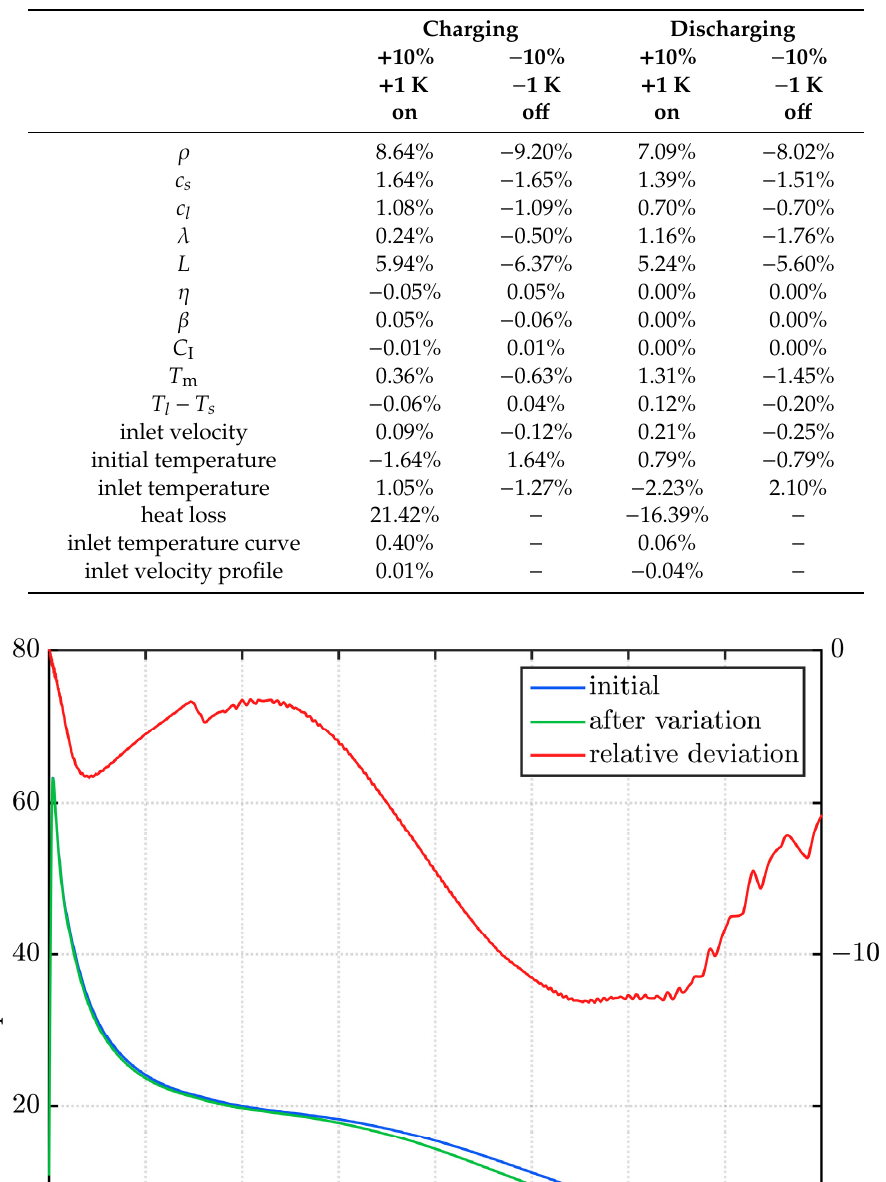
Table A3. Overview of the influence on the magnitude of the mean power for all varied material properties as well as boundary and initial conditions. The charging and discharging power is always defined positive.